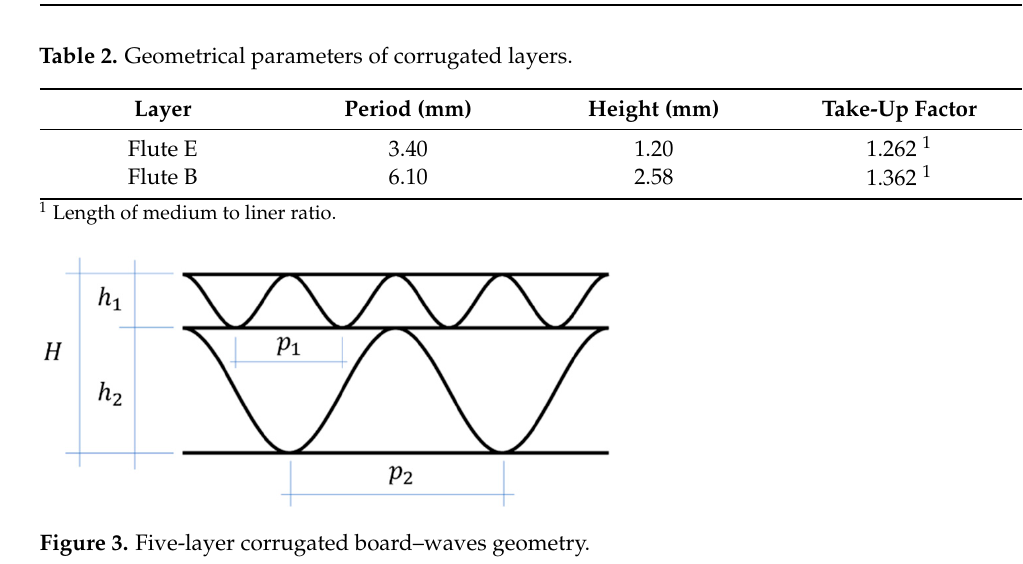
Table 2. Geometrical parameters of corrugated layers. Layer